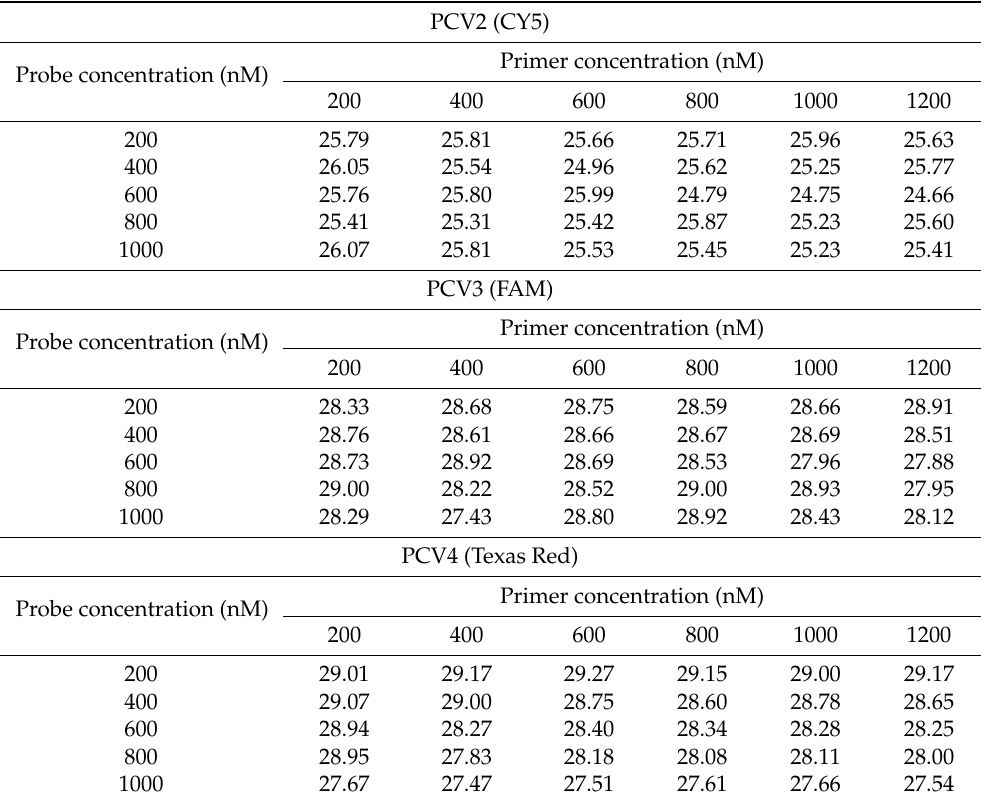
Table 2. Optimization of primer and probe concentrations. CT values of PCV2, PCV3, and PCV4 detected using multiplex TaqMan qPCR with different concentrations of probes and